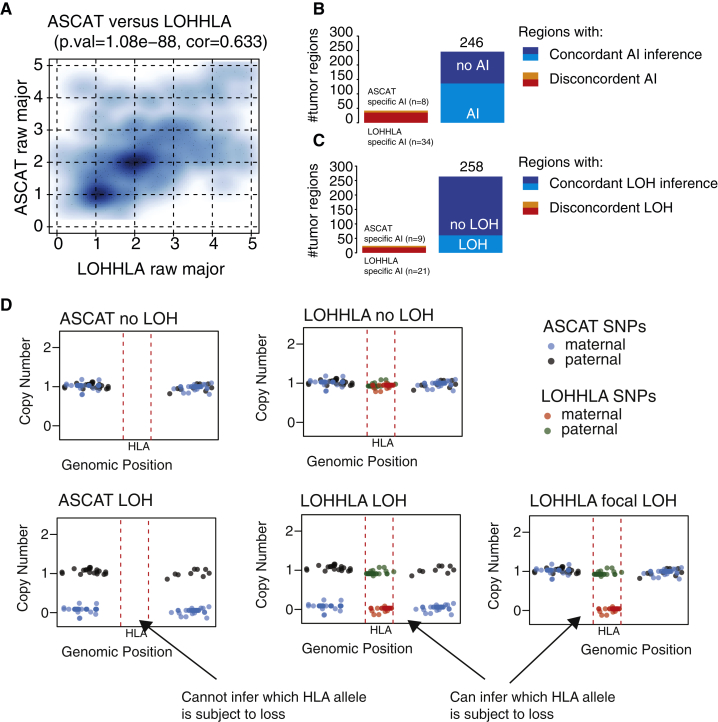
Comparison of LOHHLA and ASCAT, Related to Figure 1(A) Plot illustrating comparison of ASCAT major copy number and LOHHLA major copy number.(B and C) Summary of concordant and discordant tumor regions in terms of allelic imbalance (B) and LOH (C).(D) Schematic illustrating how ASCAT cannot directly infer HLA copy number or which HLA allele is subject to loss. By contrast, LOHHLA uses SNPs covering HLA genes to directly infer HLA copy number.